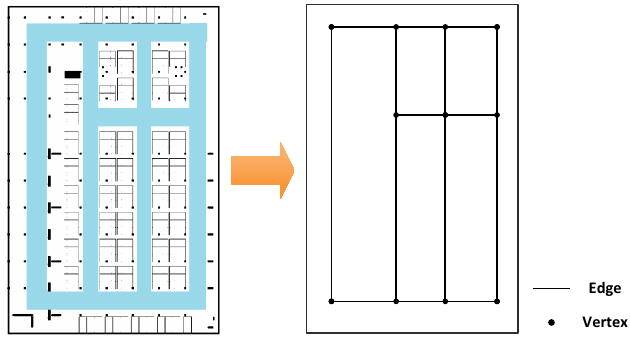
Figure 5. The indoor map is handled as a pathway graph in this paper: ( a ) a floor plan of an underground parking, the blue line is the pathway; ( b ) pathway graph of the left floor plan, the edges represent roads and the vertexes represent connections between roads.